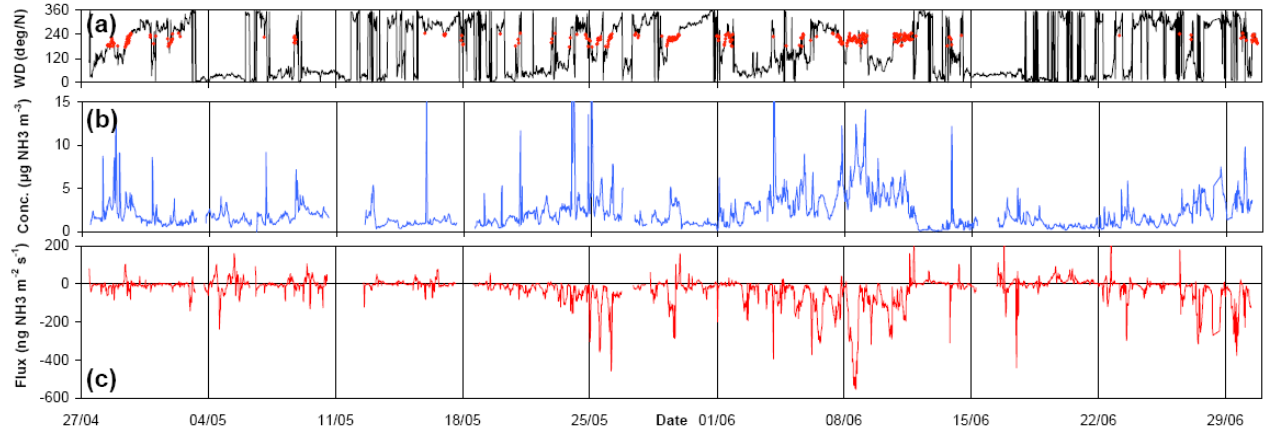
Fig. 6. Wind direction, NH 3 concentrations and fluxes: (a) wind direction (WD) (in red dots the periods when the wind was coming from the farm are highlighted), (b) NH 3 concentration (Conc.), and (c) fluxes ( F NH3 ) at 1 m above the displacement height d .